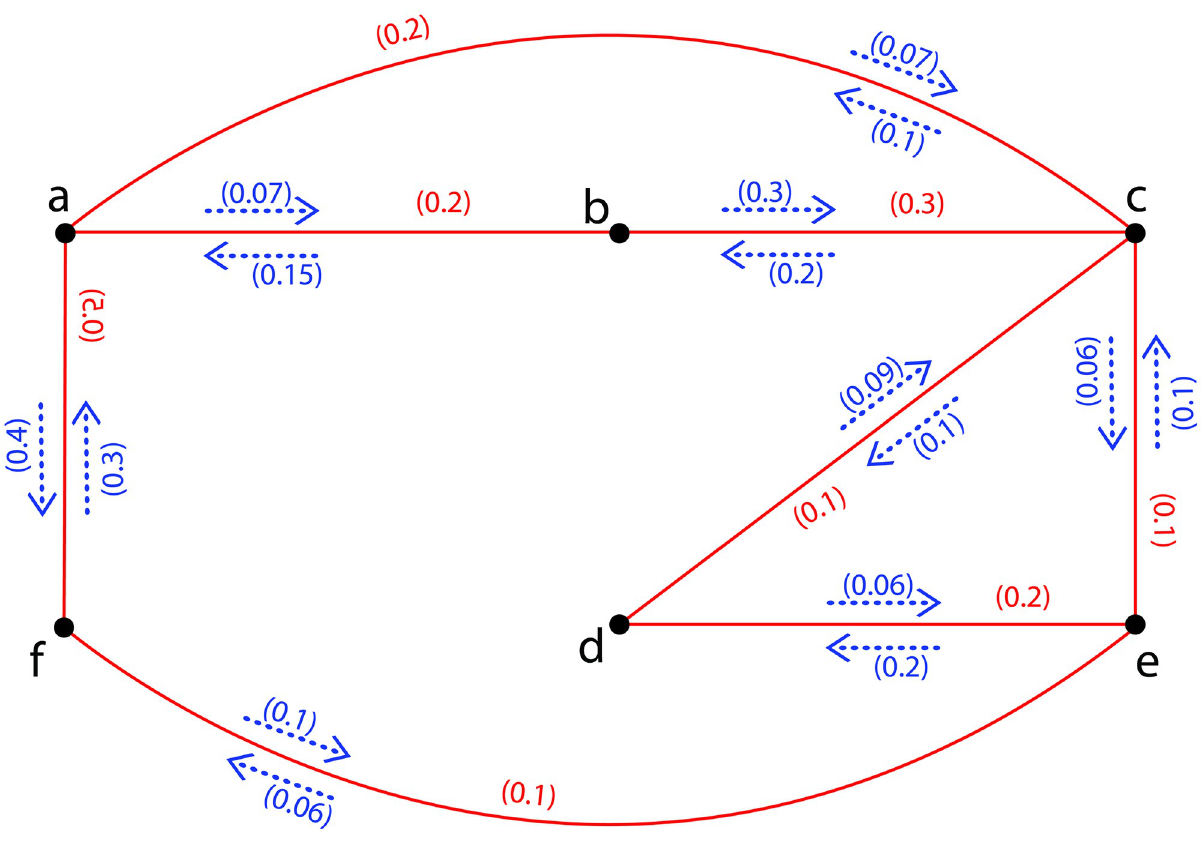
Fig 4. A FIG with FICCVs , FICBs and FICCPs